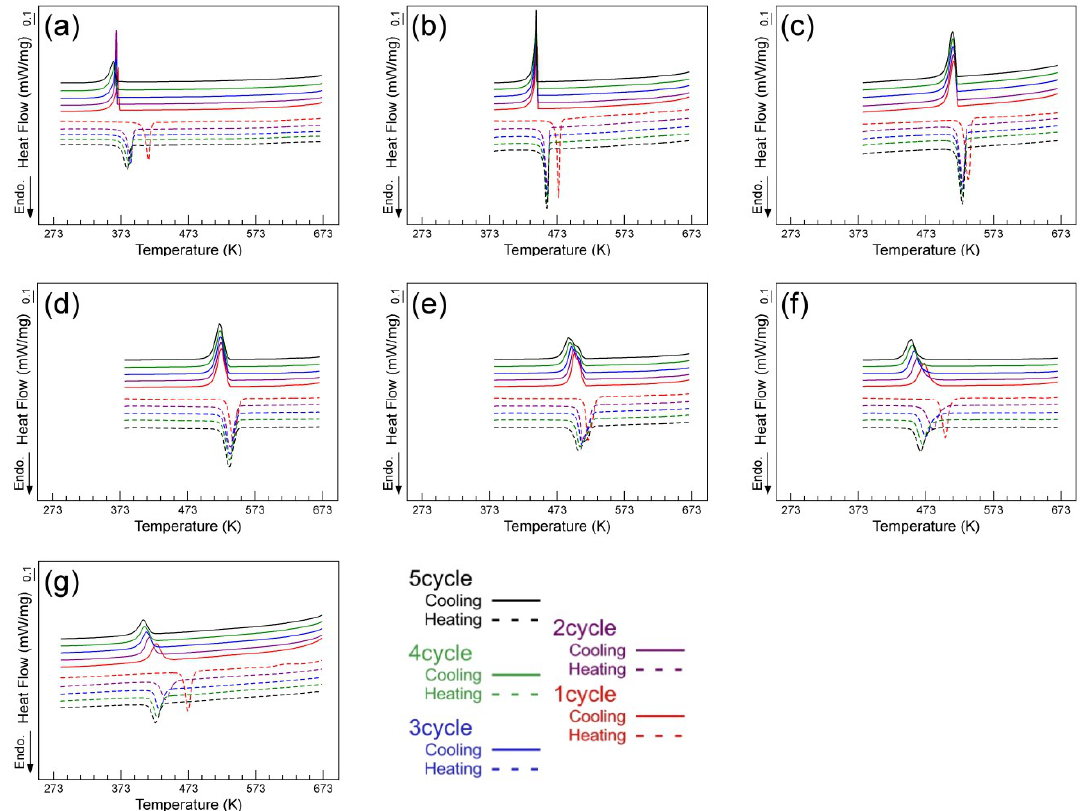
Figure 2. Differential scanning calorimetry (DSC) curves of the (49–51)Ti alloys solution treated at 1173 K. ( a ) 49Ti alloy; ( b ) 49.5Ti alloy; ( c ) 50Ti alloy; ( d ) 50.5Ti alloy; ( e ) 51Ti alloy; ( f ) 51.5Ti alloy; ( g ) 52Ti alloy.